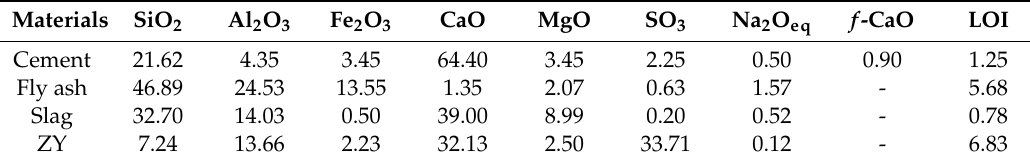
Table 1. Chemical compositions of cement, fly ash, slag, and ZY-type ™ expansive agent (wt.%).